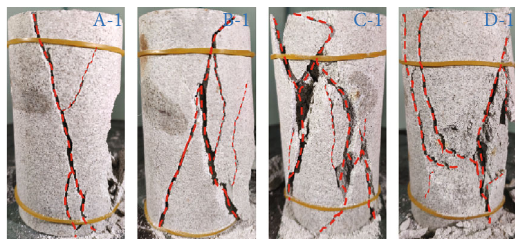
Figure 11: Failure modes of samples with di ff erent water contents.